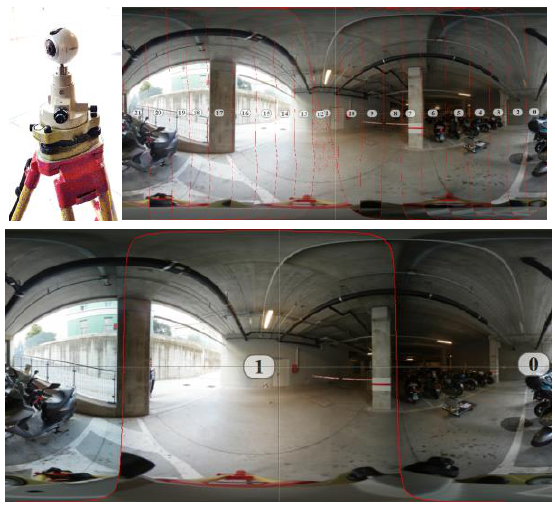
Fig. 4. The special calibration tool used to estimate the relative orientation between front and rear facing images. PTGui project with all images and the final result in which only a pair of front and rear facing images are used for generating the equirectangular projection.